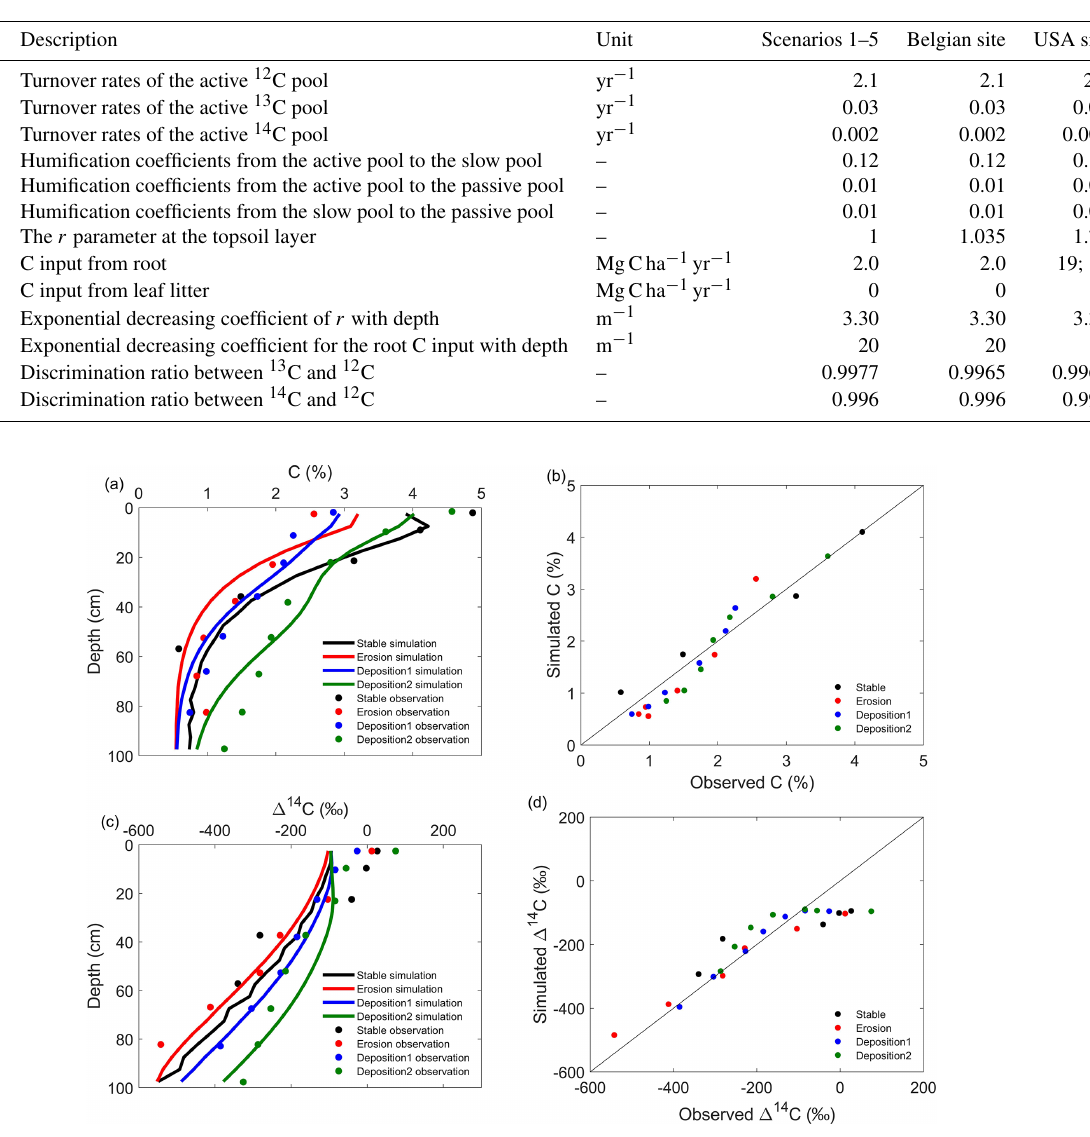
Table 1. Values of parameters for SOC cycling used this study.